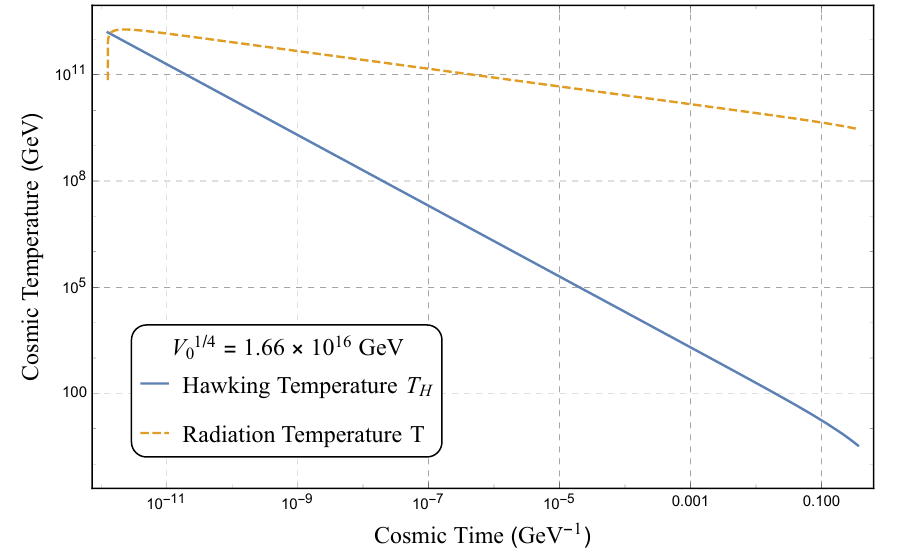
Figure 9. Hawking Temperature T H = H φ / 2 π , with H φ being the Hubble parameter from the energy density ρ of the inflaton oscillations, and new radiation temperature T versus cosmic time φ for successful inflation with V 1 / 4 = 1 . 66 × 10 16 GeV. The new radiation temperature T starts 0 dominating over T after cosmic time 1 . 37 × 10 − 12 GeV − 1 , and inflation ends at τ = 1 . 26 × H 10 − 12 GeV − 1